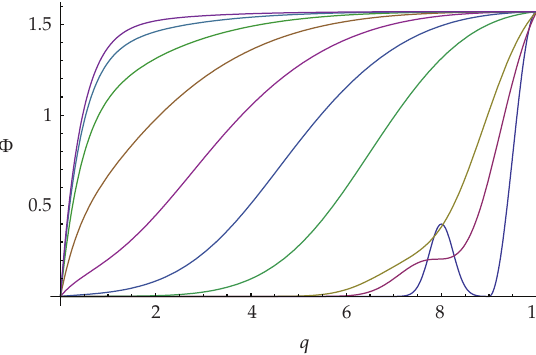
Figure 1: Propagation of the traveling wave Φ(cid:2) τ,q (cid:3) in a TNC for the moving coordinate system. Parameters of the method: J (cid:7) 7, Δ τ (cid:7) 0 . 005; parameters of the problem: v (cid:7) 2, q 1 (cid:7) 0, 2 q 2 (cid:7) 10, σ (cid:7) 0 . 25, q 3 (cid:7) 8.